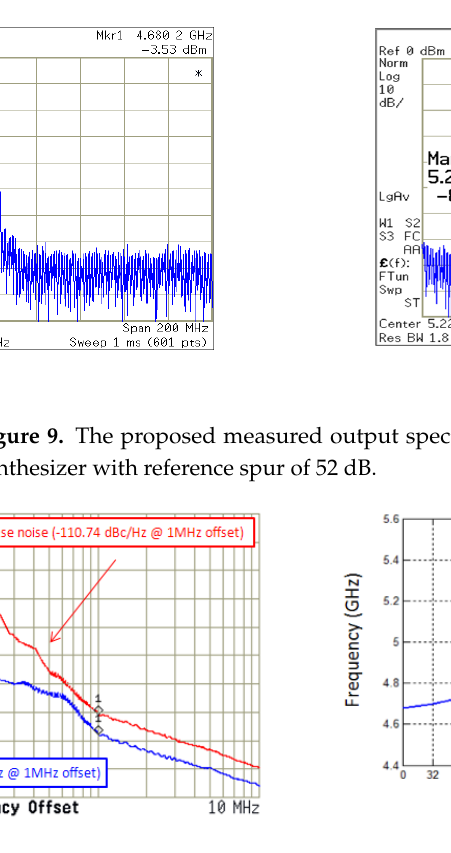
Table 1. Performance comparisons with previously published papers.